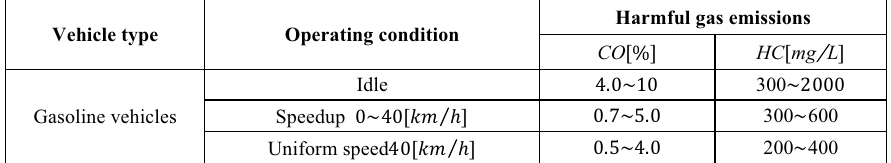
Table 4. The amount of harmful gas produced by vehicles under different